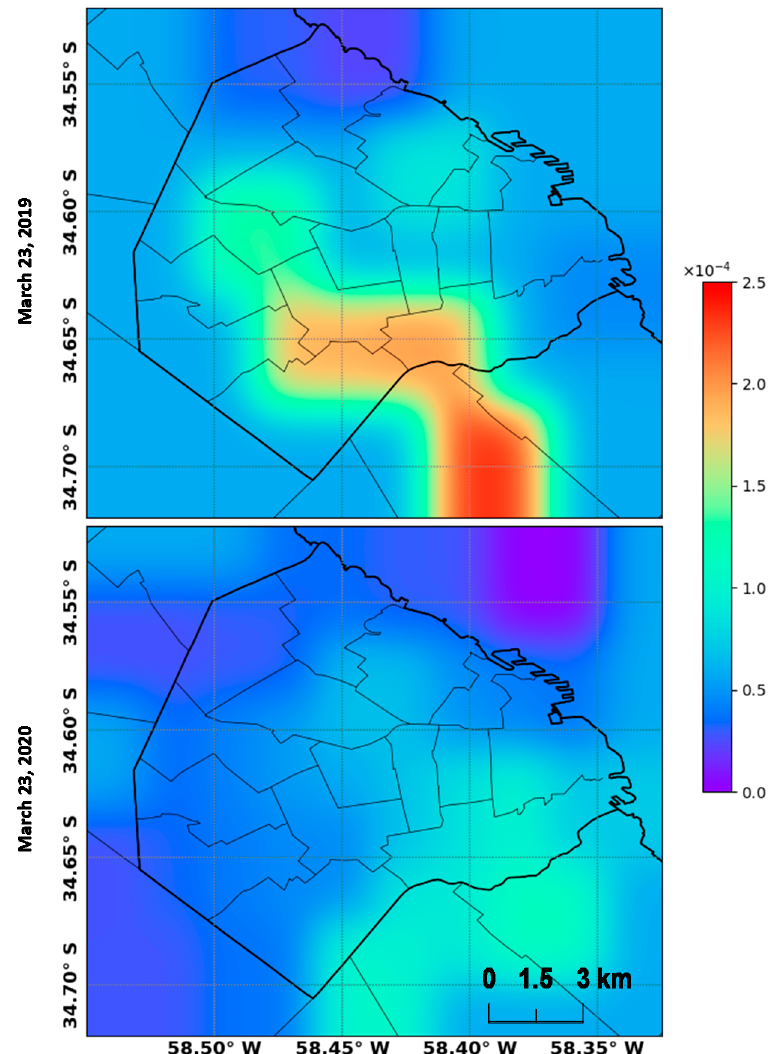
Figure 3. The level of tropospheric NO 2 (moles/m 2 ) measured by the S5p/TROPOMI-ESA [30,31] both in the same day (23 March) and different years in CABA.